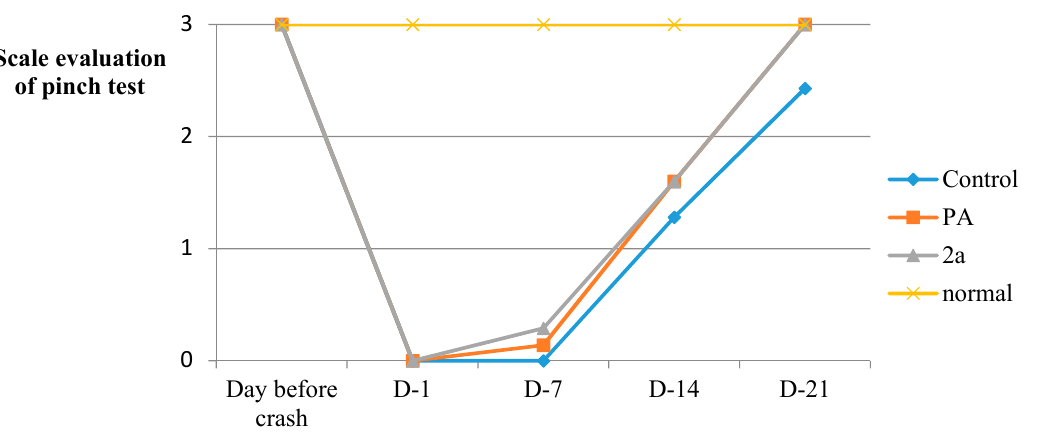
Figure 7. Pinch test (S.D. < 10%).